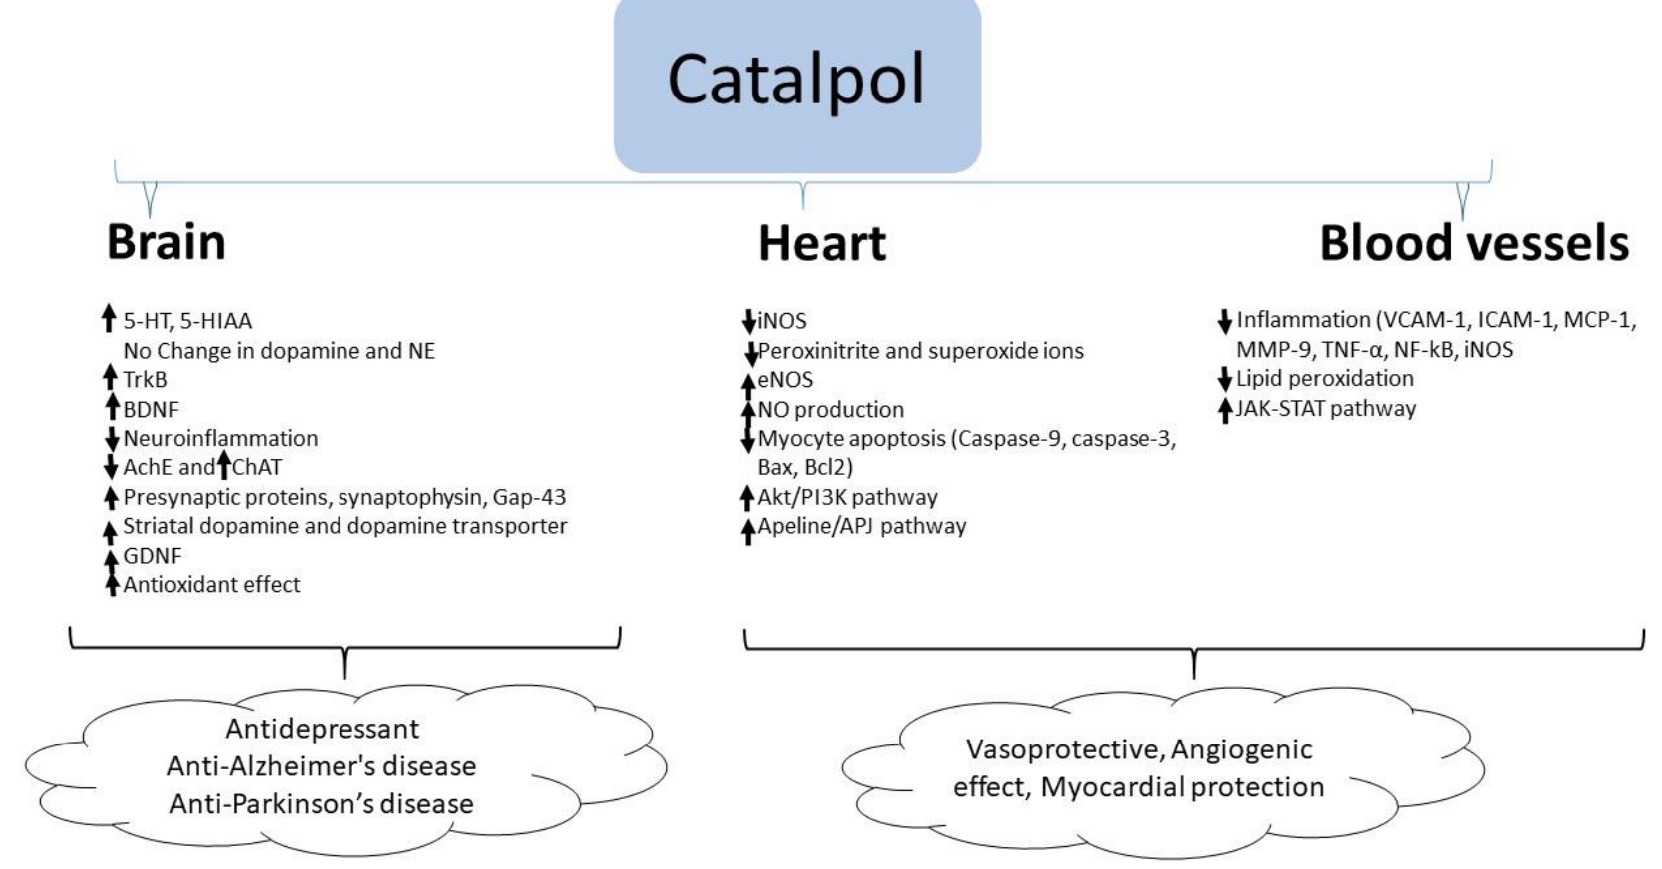
Figure 2. Molecular changes by catalpol for the protection of brain, heart, and blood vessels.